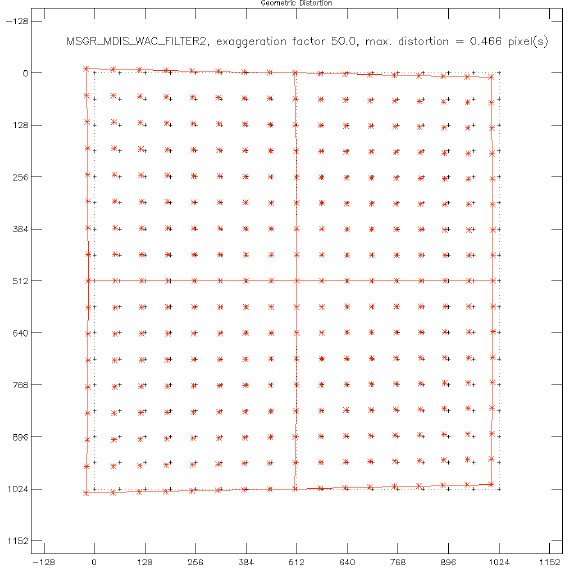
Figure 1: Geometric distortion of WAC Filter B (exaggerated by a factor of 50).